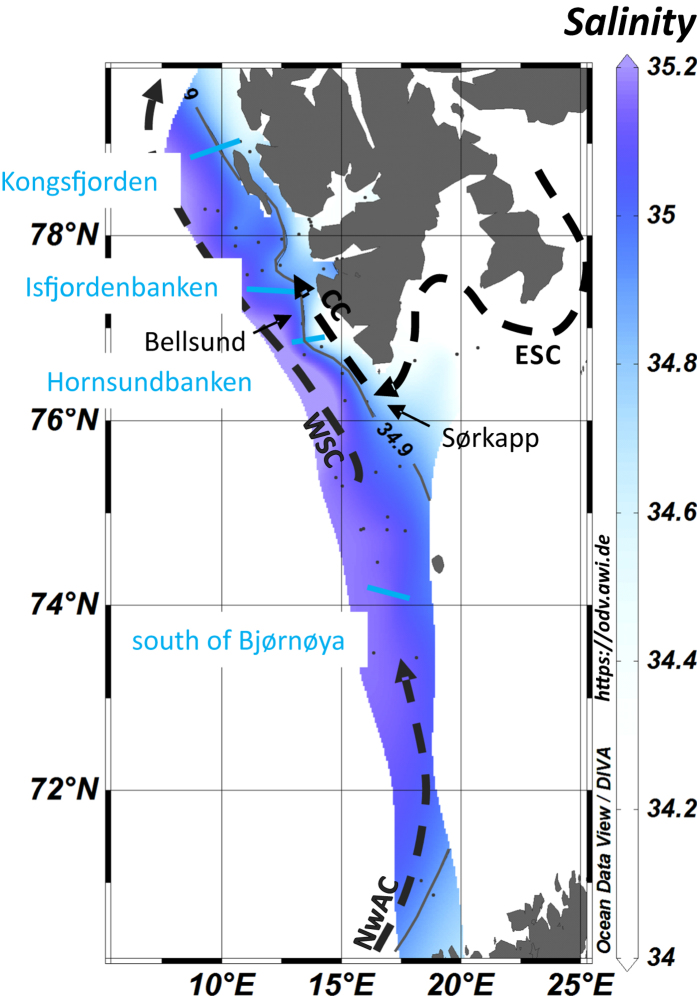
Contour plot of salinities observed in the 100–200 m water depth layer.The contour of a salinity of 34.9 indicates the Arctic front between saline, warm Atlantic Water and fresher, cold Arctic Surface Water. The Atlantic Water is carried by the Norwegian Atlantic Current (NwAC) and the West Spitsbergen Current (WSC) (dark gray arrows). The Arctic Surface Water is carried by the East Spitsbergen Current (ESC) and the Coastal Current (CC) (black arrows). The locations of the transects of Supplementary Figure S2 online are shown as blue lines. The water mass Melt/Surface Water (MSW) occurred in depths shallower than 100 m and is, thus, not shown here. The plot was generated using Ocean Data View Version 4.5.7 (https://odv.awi.de) and DIVA gridding.